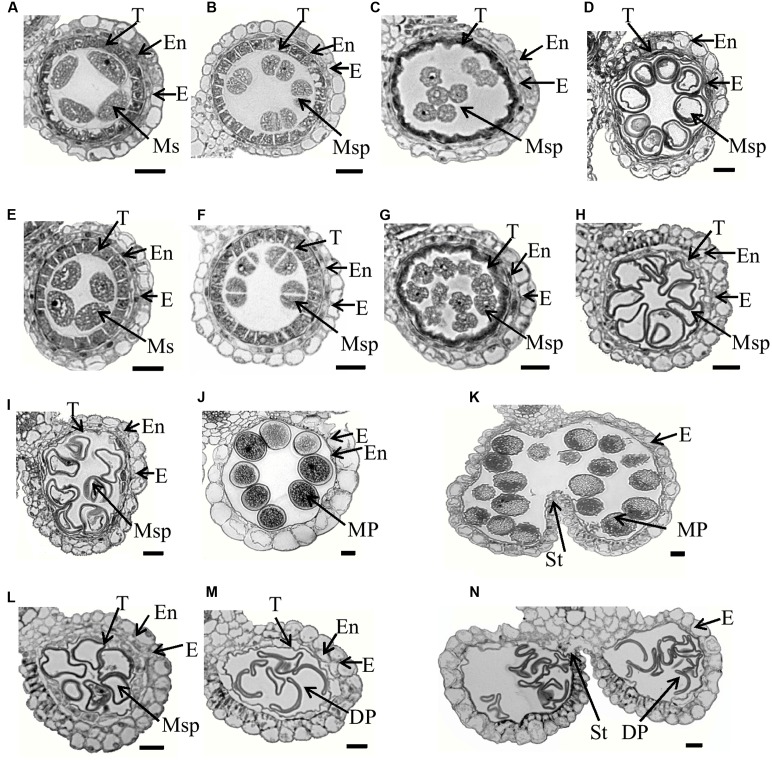
Semi-thin section comparison of anther development in the WT and the Osfignl1 mutant. (A–D) and (I–K) show the WT; (E–H) and (L–N) show the Osfignl1 mutant. (A,E) Meiosis stage. (B,F) Tetrads stage. (C,G) Young microspore stage. (D,H) Vacuolated pollen stage. (I,L) Bicellular pollen stage. (J,M) Mature pollen stage. (K,N) Anther dehiscence stage. E, epidermis; En, endothecium; DP, defective pollen; MP, mature pollen; T, tapetum; Ms, microsporocyte; Msp, microspore; St, stomium. Bars = 20 μm.